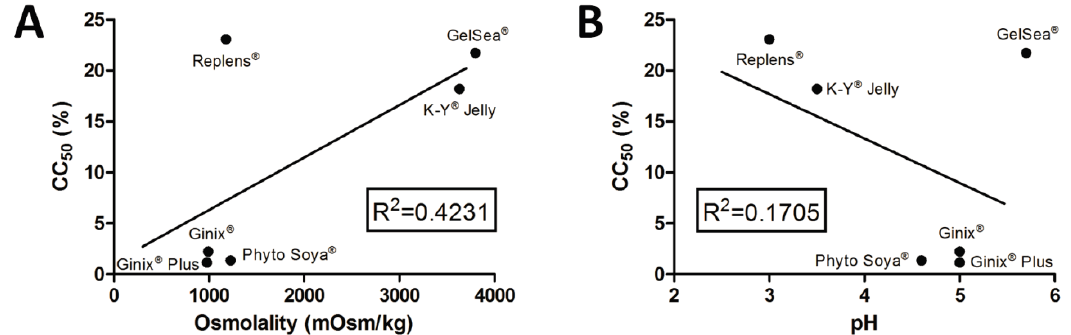
Figure 4. Correlation of cytotoxicity, expressed as half-maximal cytotoxic concentration (CC ) values, with the ( A ) osmolality or ( B ) pH of the selected products. Individual points 50 are mean values, and the straight line corresponds to linear regression ( R 2 values presented in the